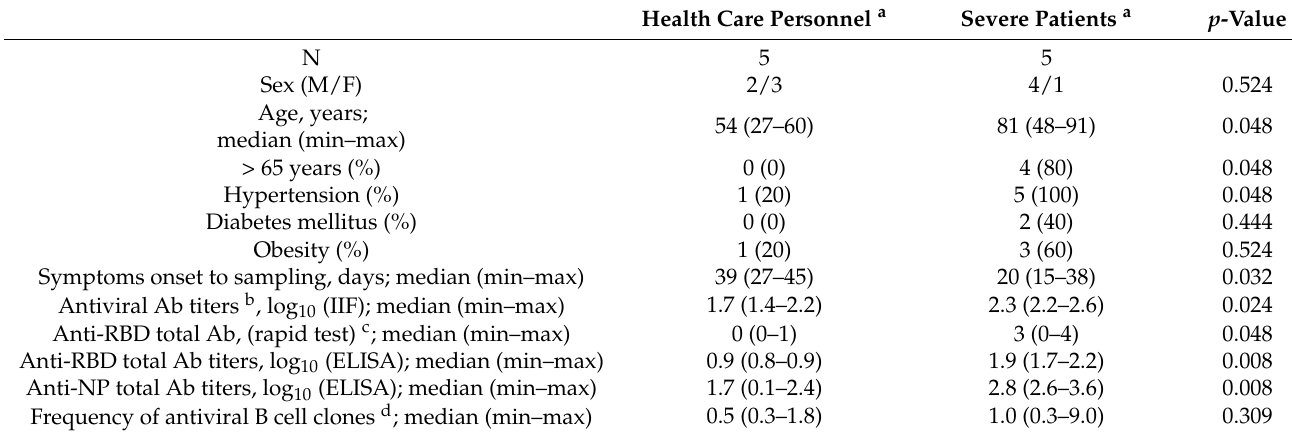
Table 1. Antiviral B cell responses of convalescent SARS-CoV-2 infected patients. Health Care Personnel a Severe Patients a p